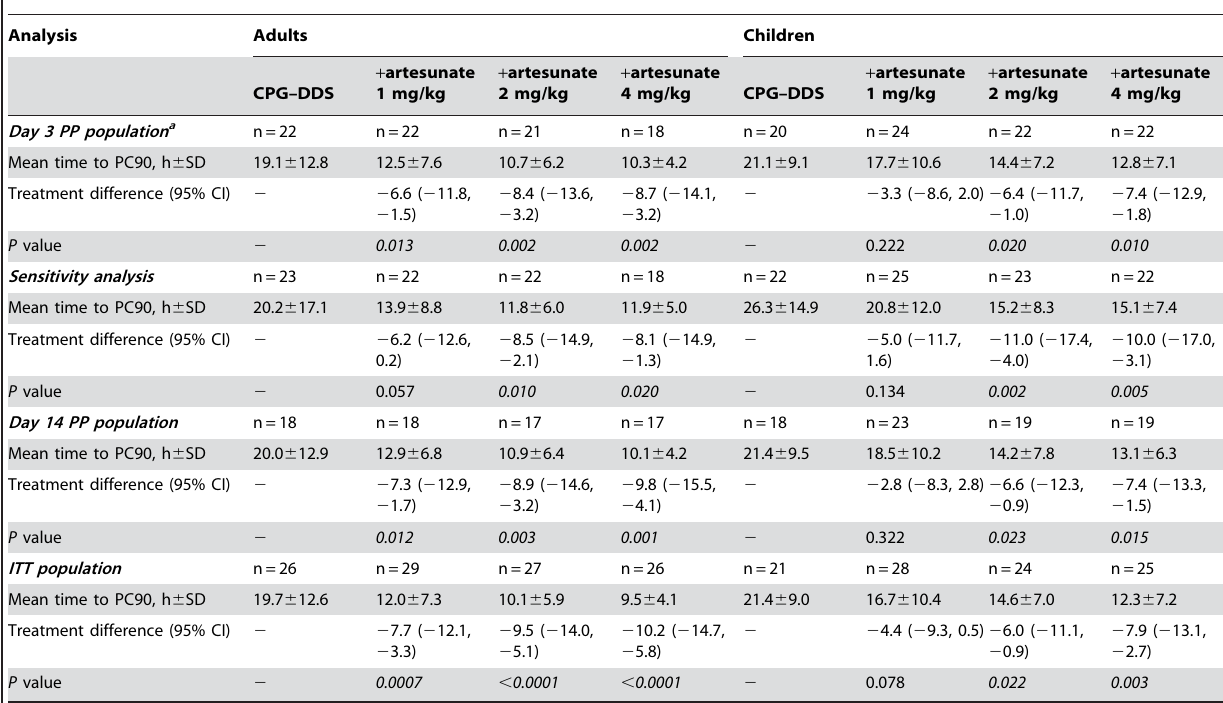
Table 2. Mean time to PC90 (primary endpoint) for the Day 3 per-protocol (PP) population (principal analysis population) and supportive analyses: sensitivity analysis on the Day 3 PP population and outcomes for the Day 14 PP population and the intent to treat (ITT)